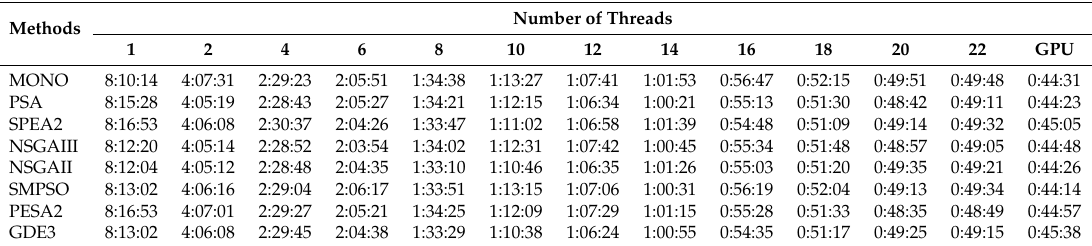
Table 4. Time performance of Multi-Objective Natural Optimization (MONO), other parallel Simulated Annealing (SA) approaches and multiobjective evolutionary algorithms (MOEAs) metaheuristics on the SOFIA method.